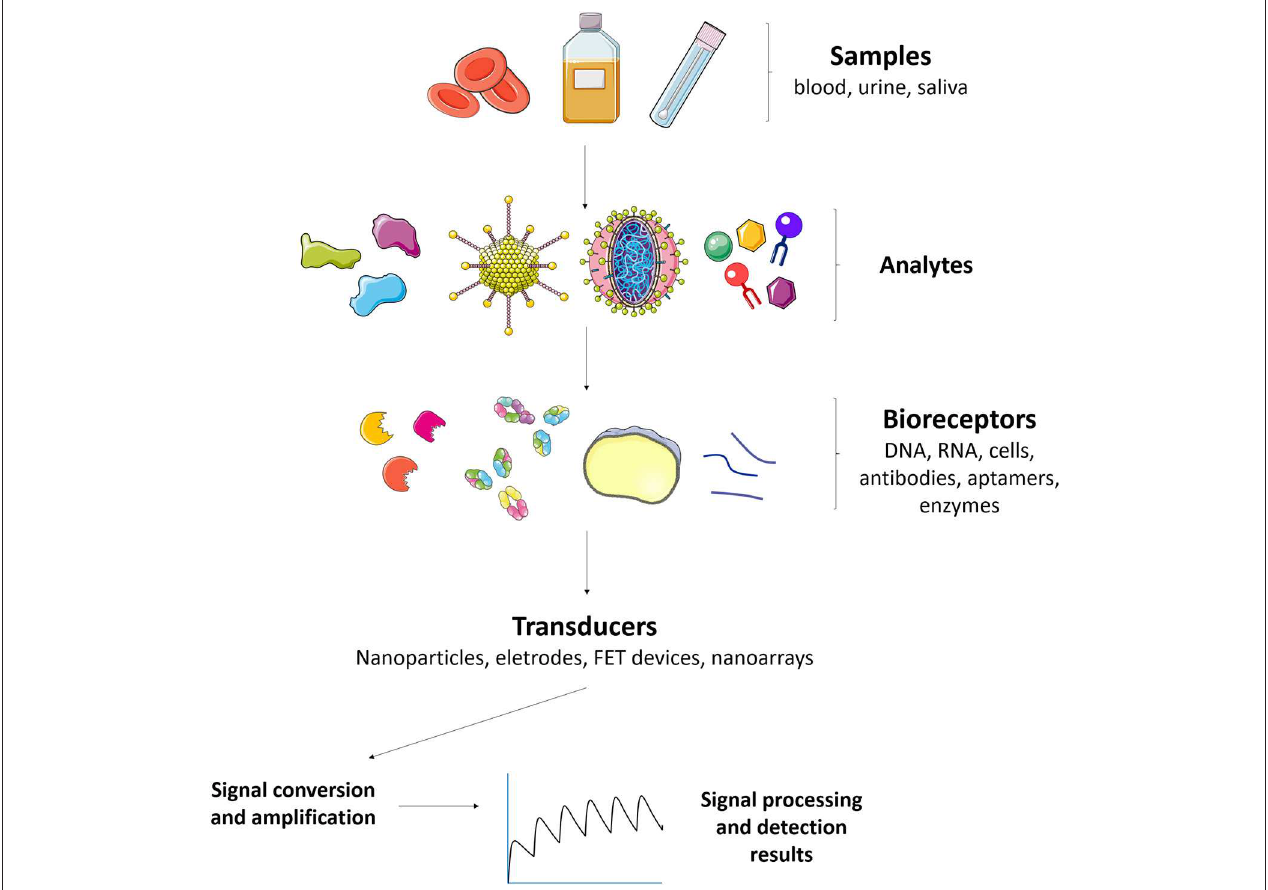
FIGURE 2 | Major constituents of a biosensor for arboviruses detection and control. Different kinds of samples (blood, urine, saliva) can be used to detect analytes such as NS1 antigen and IgM antidengue, zika, and/or chikungunya antibodies. The analytes can interact with bioreceptors (aptamers, gold nanoparticles, glycan, fluorophores, enzymes, viral antigens, nucleic acids, and polyclonal antibodies for instance) that are connected to transducers and the signal converted and amplified in order to monitor the arboviruses.